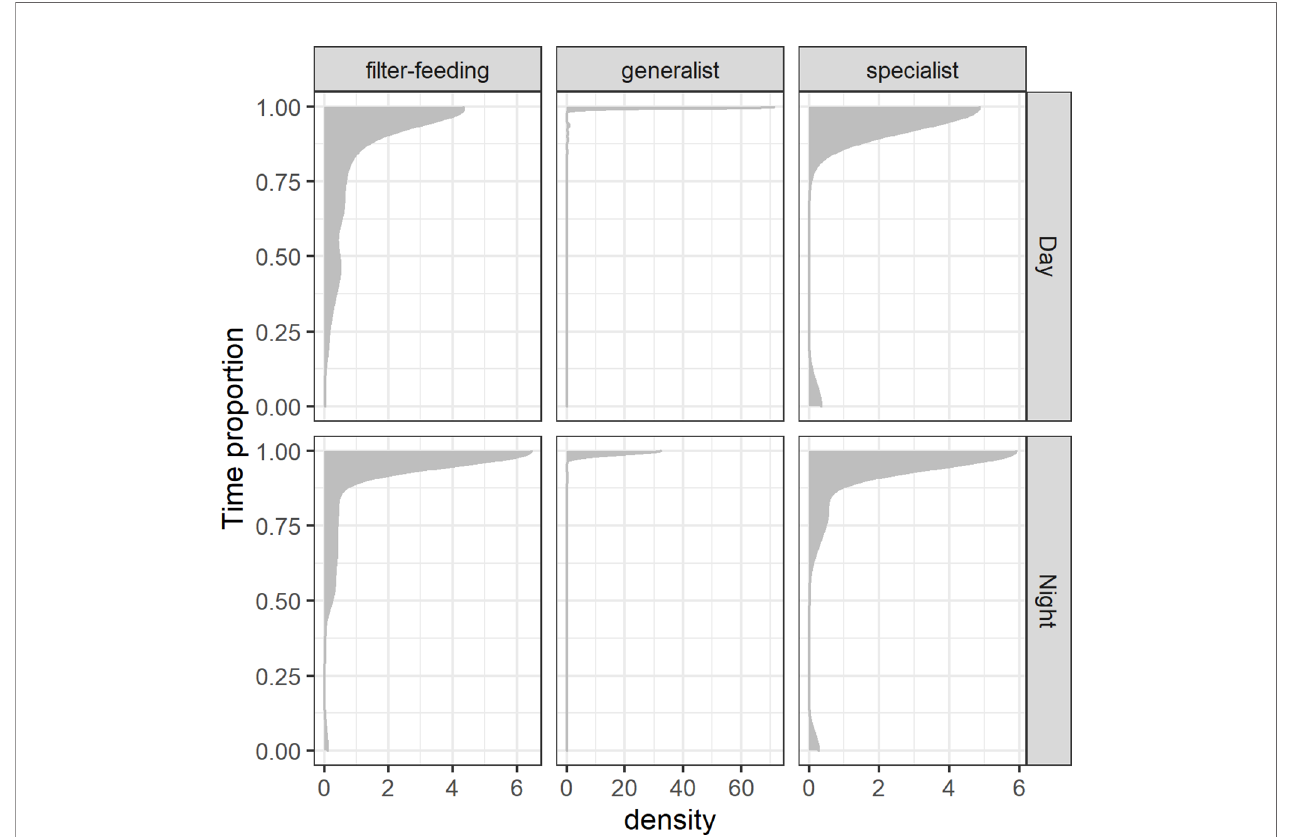
FIGURE 6 | Density plot of the smooth distribution of the proportion of time spent in epipelagic waters ( ≤ 200 m in depth; T200 ) by pelagic elasmobranchs grouped by their feeding habits ( fi lter-feeding, generalist, specialist) and across the diel cycle (night and day).